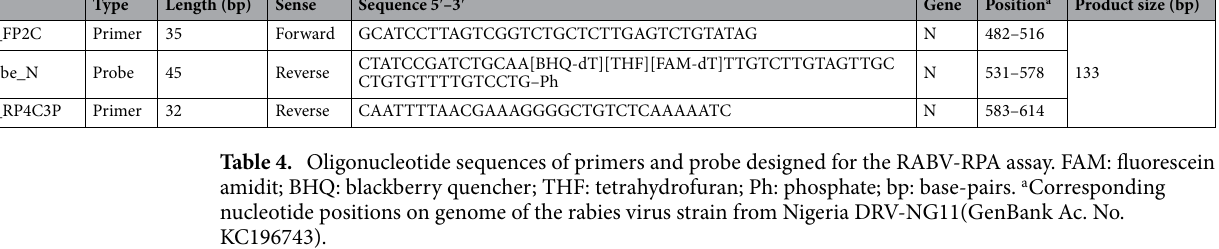
(Table 1). Positive and negative controls containing standard RNA and nuclease-free water were included in each run. The real-time RT-qPCR assay was used as reference test and was performed using the Quantitect Probe RT-PCR Kit (Qiagen, Heiden, Germany) in a final volume of 25 μl following previously published protocol 19 . Amplicons obtained with the RABV-RPA assay from five isolates from Niger (90010NIG), Brazil (86001BRE), Afghanistan (02052AFG), Cambodia (99008CBG) and Saudi Arabia (87001ARS) (Table 2), were purified using AmPure magnetic beads (Agencourt Bioscience [Beckman Coulter Inc.], Beverly, MA, USA), and adapters were ligated using the Nextera XT library Prep kit according to the manufacturer’s recommendations (Illumina, San Diego, CA, USA). The purified and amplified libraries were quantified using the KAPA library quantification kit (Kapa Biosystems, Wilmington, DE, USA) and subsequently sequenced on the Illumina MiSeq platform with 76 bp paired-end reads using the Miseq reagents kit v3 according to the manufacturer’s protocol (Illumina, San Diego, CA, USA). Reads were quality trimmed using Prinseq-lite, and de novo genome assembly was performed with IDBA (Iterative de Bruijn graph De Novo Assembler). The coverage and the identity of obtained sequences to the target region were verified using a BLAST analysis (https ://blast .ncbi.nlm.nih.gov/).